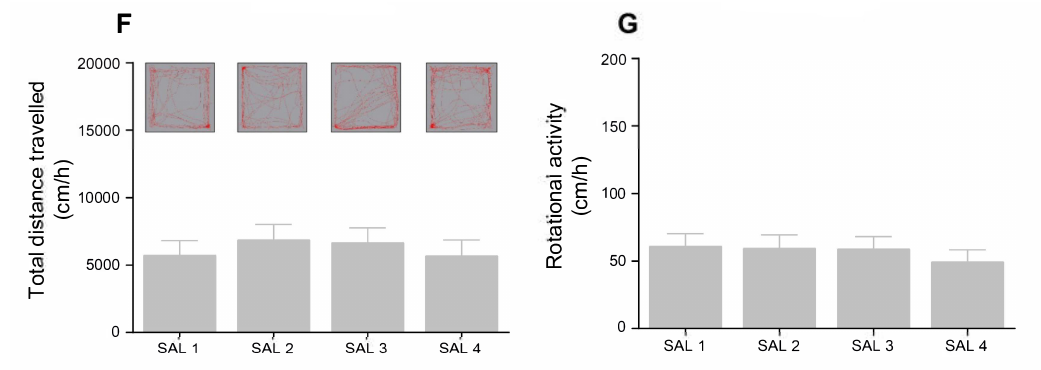
Figure 1. E ff ects of 1-(1-(4-fluorophenyl)cyclohexyl)piperidine (4 (cid:48) -F-PCP) on locomotor and rotational activities in mice. ( A ) Experimental timeline for open-field test of 4 (cid:48) -F-PCP. ( B , C ) Representative locomotion tracking patterns (red lines in each gray rectangle) and total distance travelled over 60 min, and temporal changes in distance travelled after administration of 4 (cid:48) -F-PCP (0, 1, 3, or 10 mg / kg, i.p.). ( D , E ) Total rotational activity over 60 min and temporal changes in rotational activity after administration of 4 (cid:48) -F-PCP (0, 1, 3, or 10 mg / kg, i.p.). ( F , G ) Representative locomotion tracking patterns with total distance travelled and rotational activity for 60 min after the administration of saline on the other alternate days. Asterisk *, **, and *** indicates p < 0.05, p < 0.01, and p < 0.001, respectively, vs. 0 mg / kg 4 (cid:48) -F-PCP group. SAL: saline. n = 12 per group.